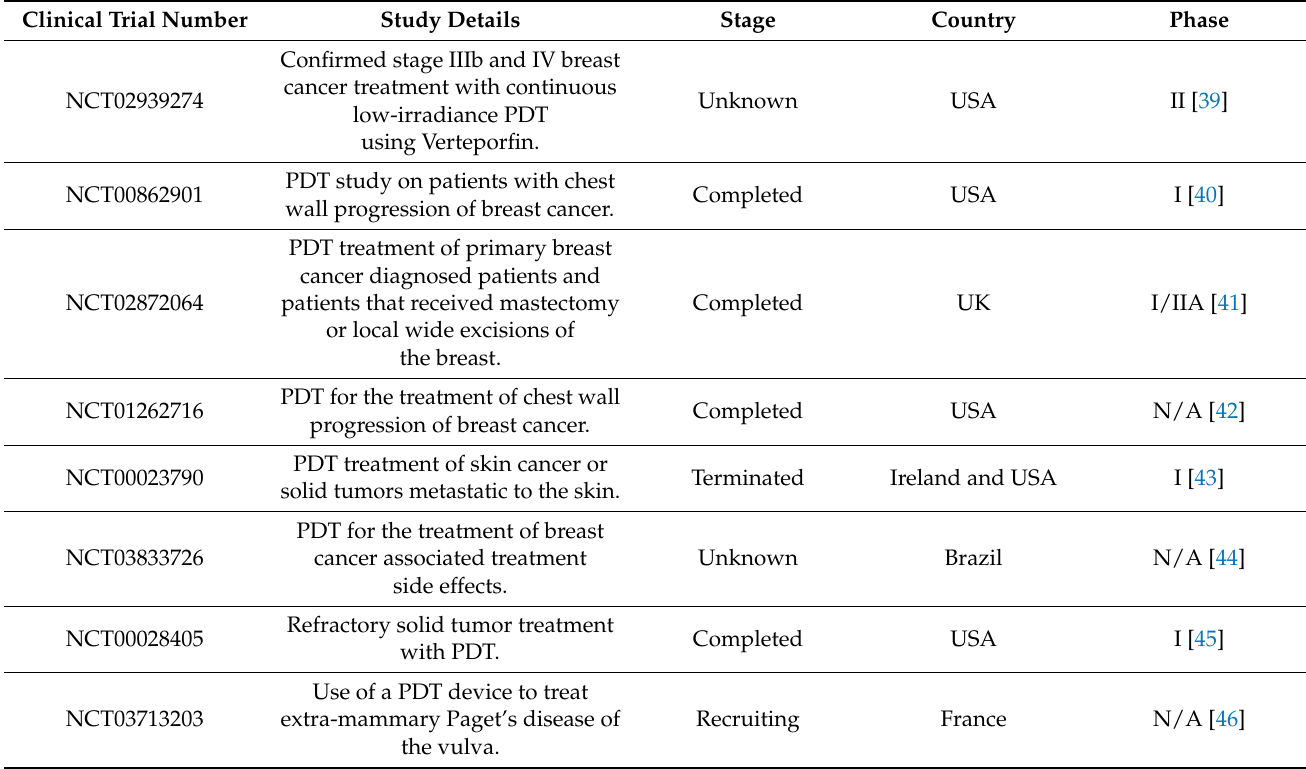
Table 1. Clinical trials on PDT of breast cancer and related conditions.